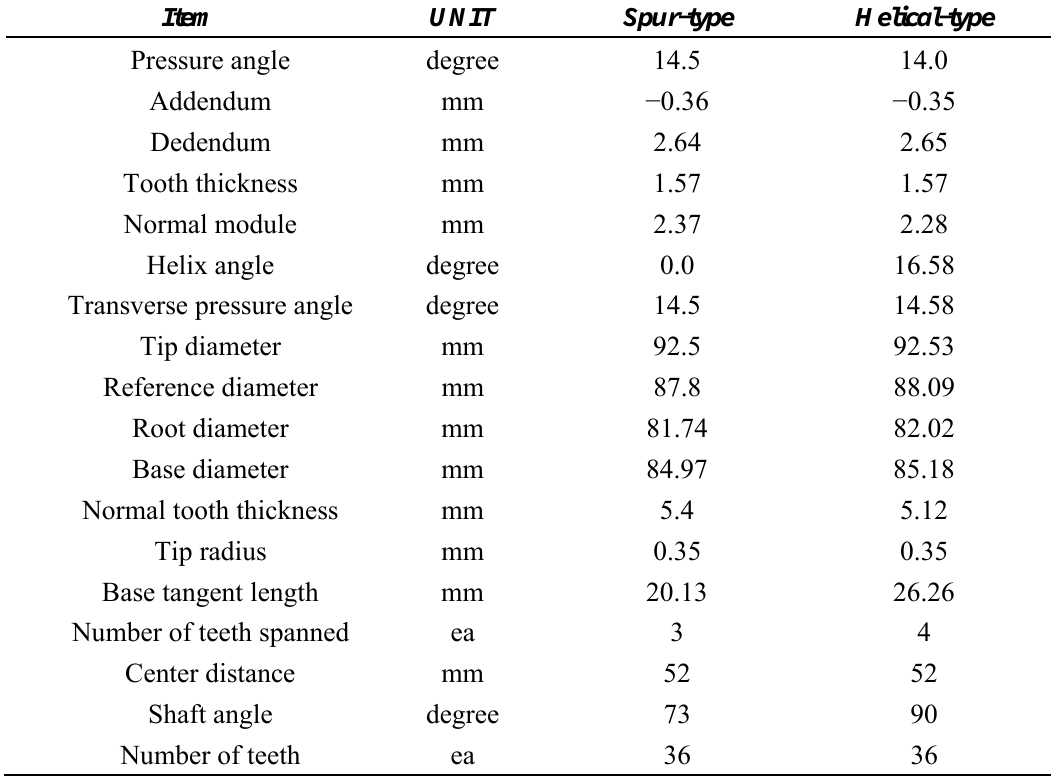
Table 1. The hub-less worm wheel specification with spur and helical tooth form.